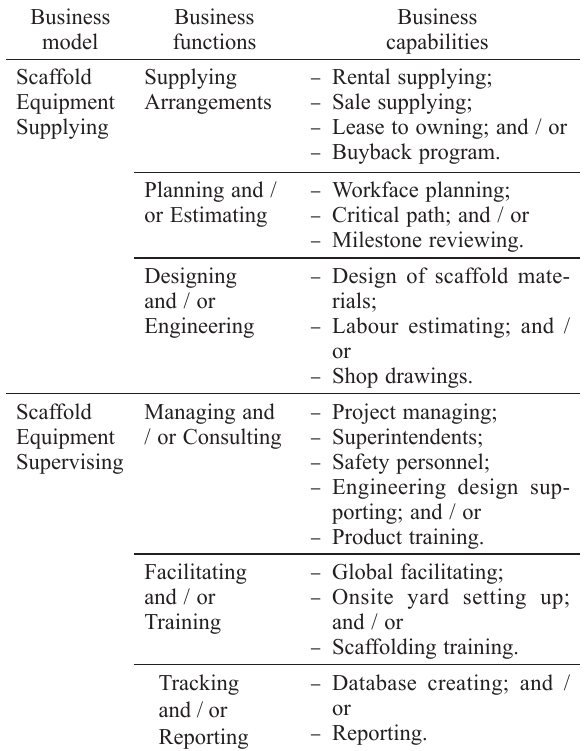
Table 3. Matrix of organisation two business functions and